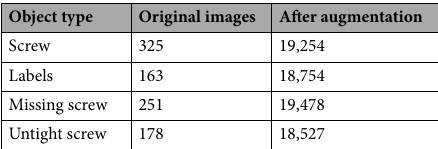
Table 1. Dataset description.